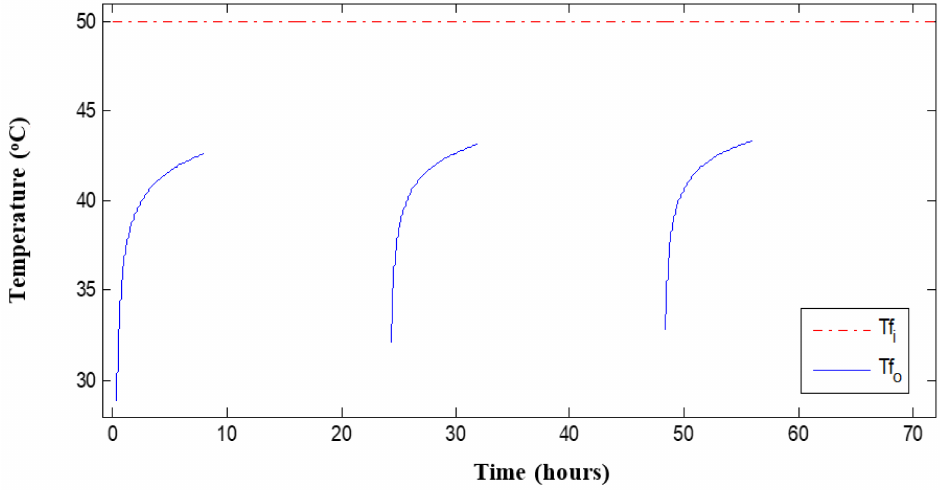
Figure 11. Profile of the fluid temperature of the horizontal to the vertical mode in